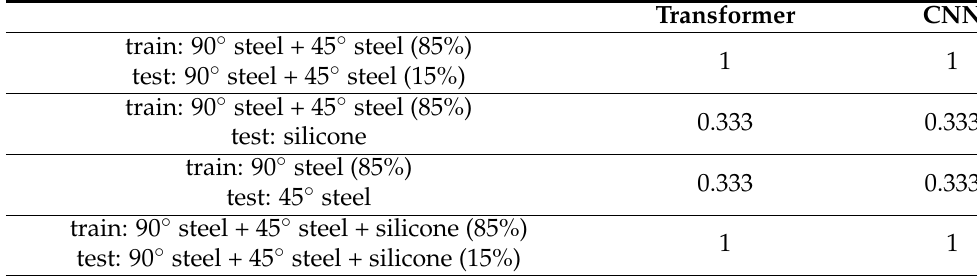
Table A1. Summary comparison table between Transformer and CNN model performance for different training and testing conditions. The percentage of data used for training and testing the models is given in parentheses, where applicable. The F1 score metric is presented for the evaluation of the models’ performance for each test.